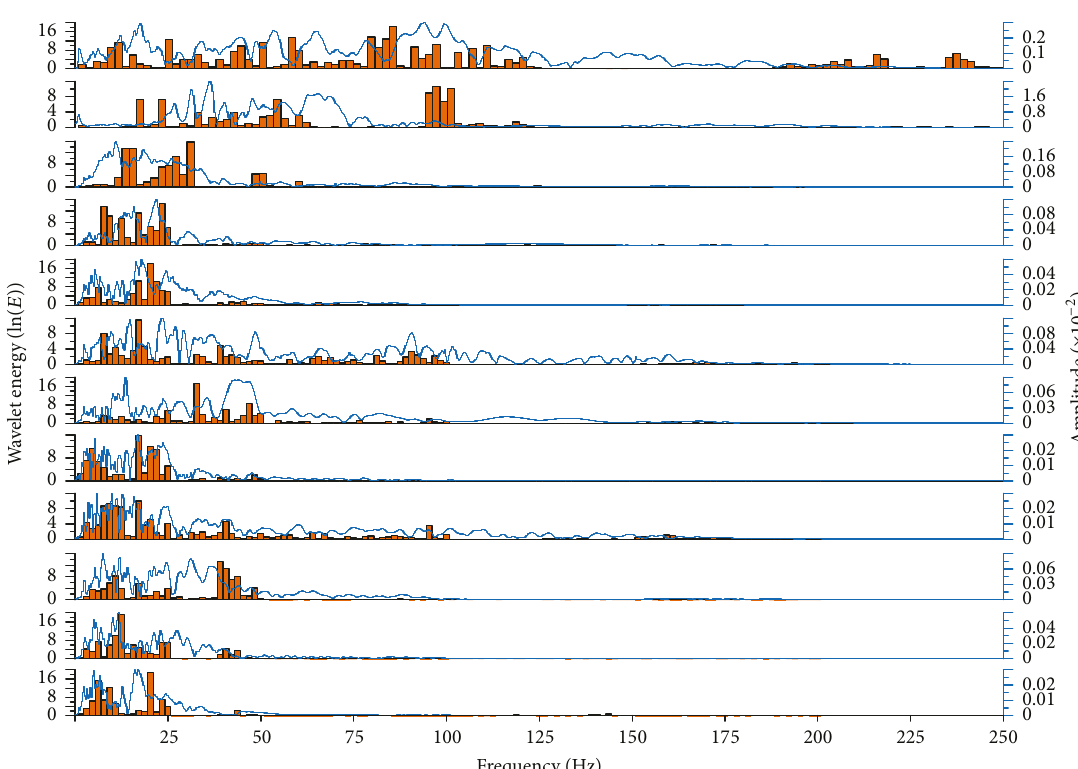
Figure 2: Congruent relation of frequency spectrum and energy distribution of microseismic wave during the remote attenuation.